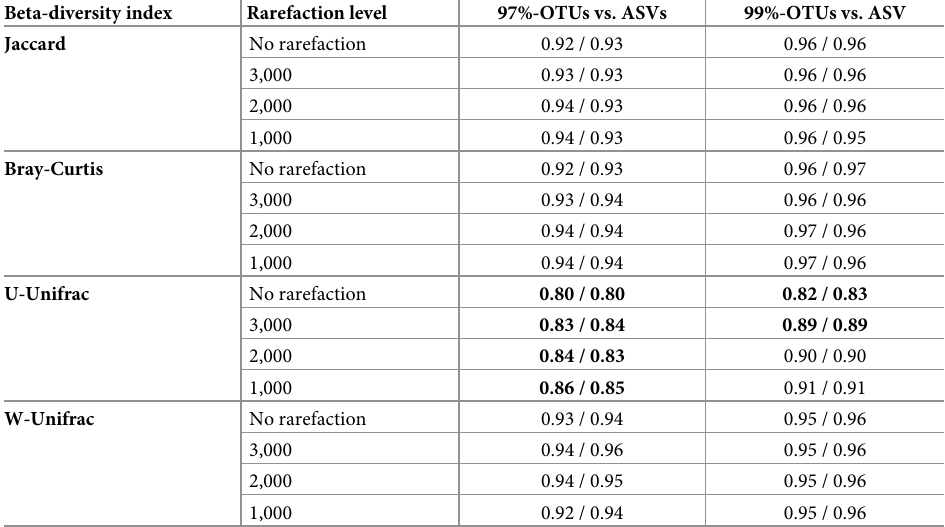
Table 2. Correlation between beta-diversity metrics between OTU- and ASV-based datasets across every rarefac- tion level